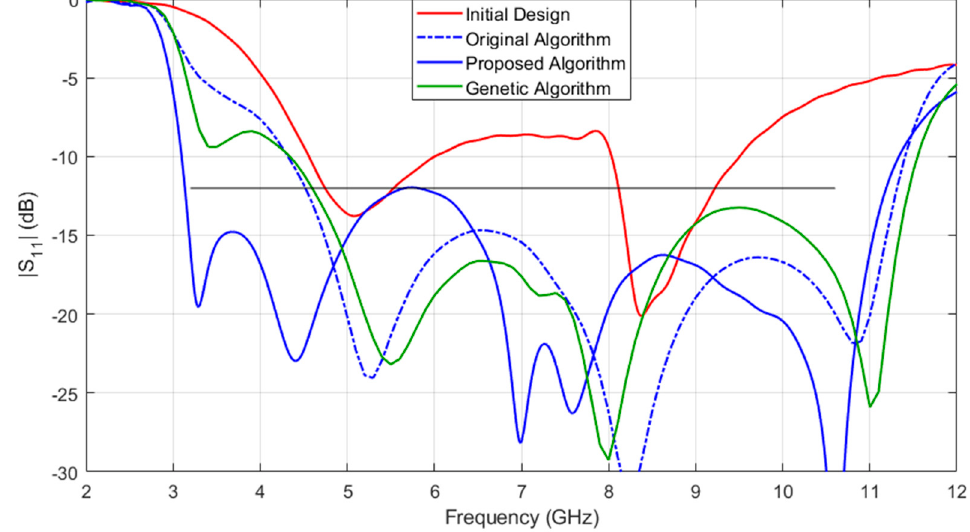
Figure 7. A UWB monopole antenna: responses of the initial design and optimal designs obtained by various algorithms.